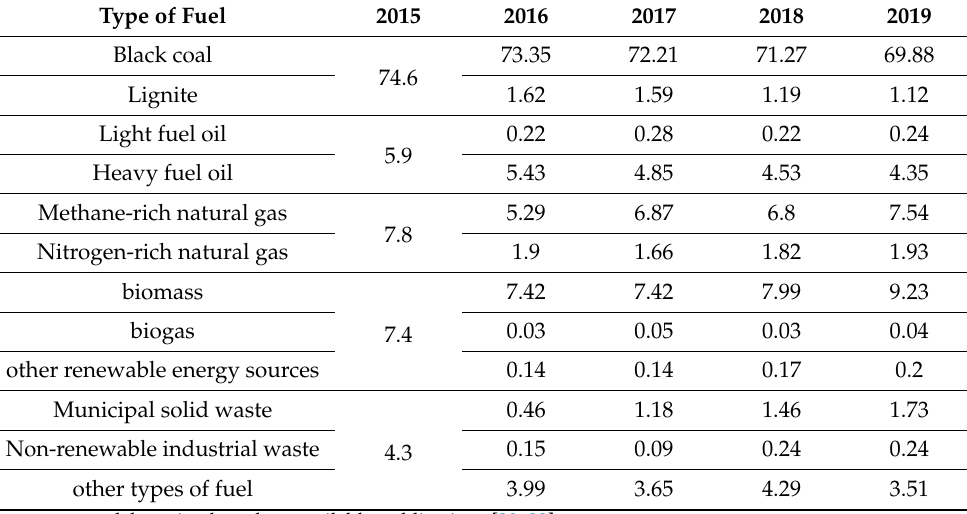
Table 3. Structure of fuels used to generate thermal energy in %.